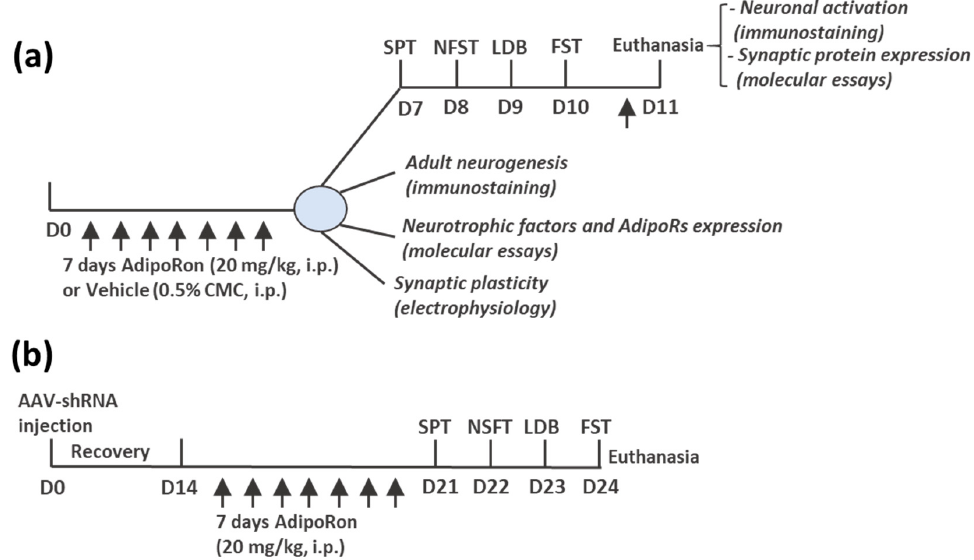
Figure 1. Experimental design. ( a ) Wild-type animals were randomly assigned to a 7-day treatment protocol with AdipoRon (20 mg/kg, i.p.) or vehicle. The day after the last injection, different cohorts of animals were subjected to behavioral, molecular, or neurophysiological experiments. The cohort subjected to behavioral analysis received an AdipoRon injection after the last behavioral test, 2 h before euthanasia. ( b ) CamKII α -Cre mice were randomly assigned to microsurgery for intrahippocampal injection of PBS (control) or adeno-associated viruses (AAV) driving the expression of shRNA targeting the N-methyl-D-aspartate (NMDA) subunits NR2A or NR2B. Fourteen days after surgery, animals were submitted to AdipoRon treatment followed by a battery of behavioral